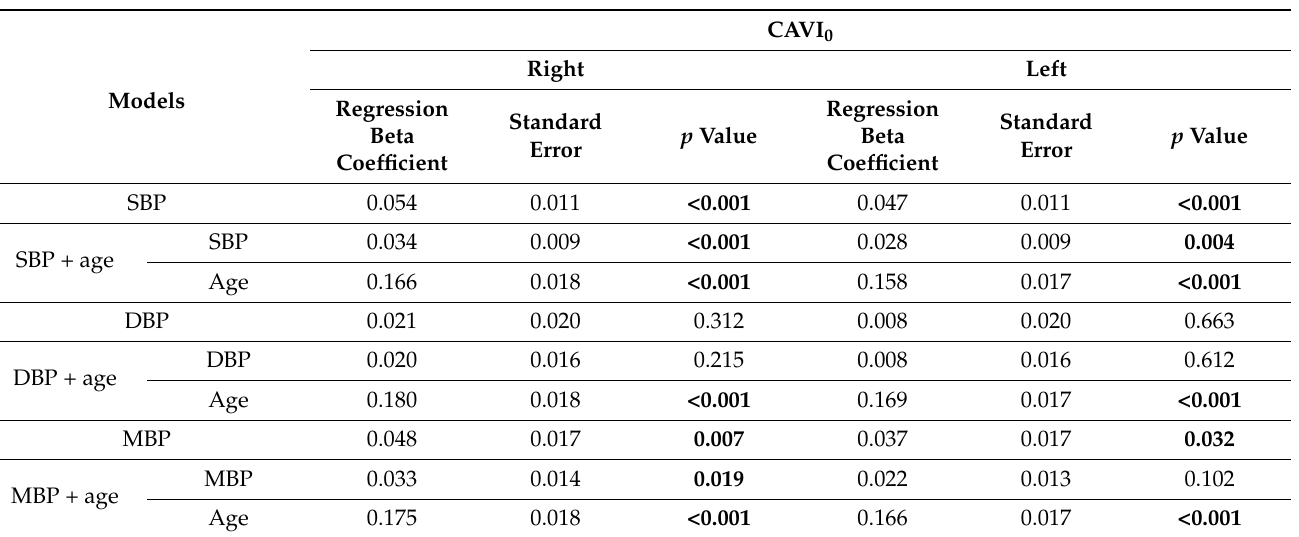
Table 5. Linear regression models to assess the independency of the association between blood pressure indices and CAVI 0